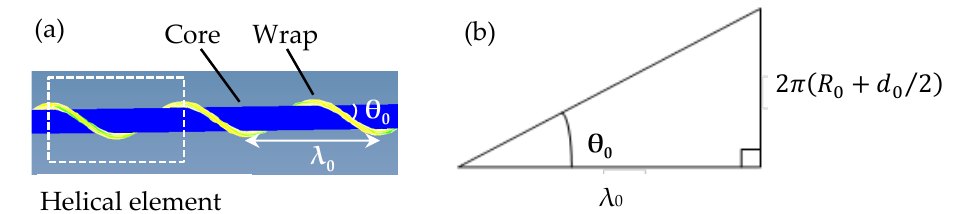
Figure 1. Structure of helical auxetic yarn: ( a ) helical wrapping structure; ( b ) expanded graph.